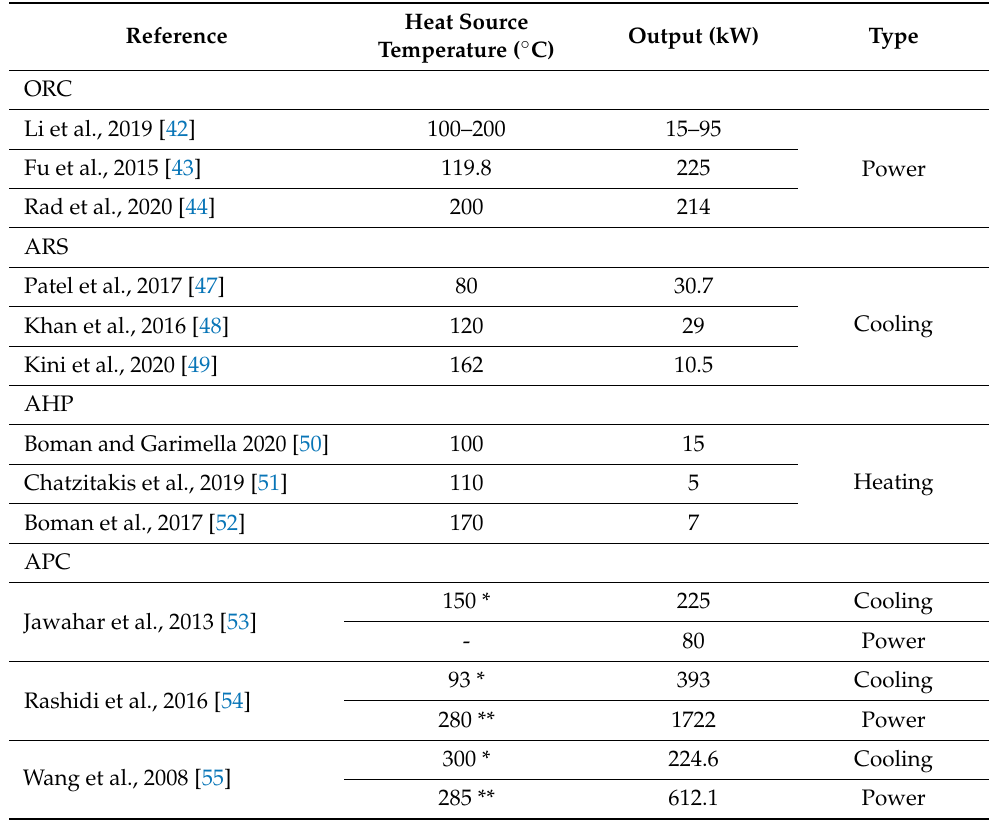
Table 1. Heat source temperature and its respective output values for the reviewed CHP technologies: ORC, ARS, AHP, and